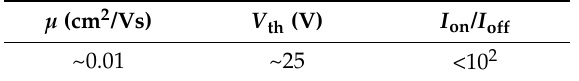
Table 3. Performance of the FET device with the RR-P3HT micropattern as an active